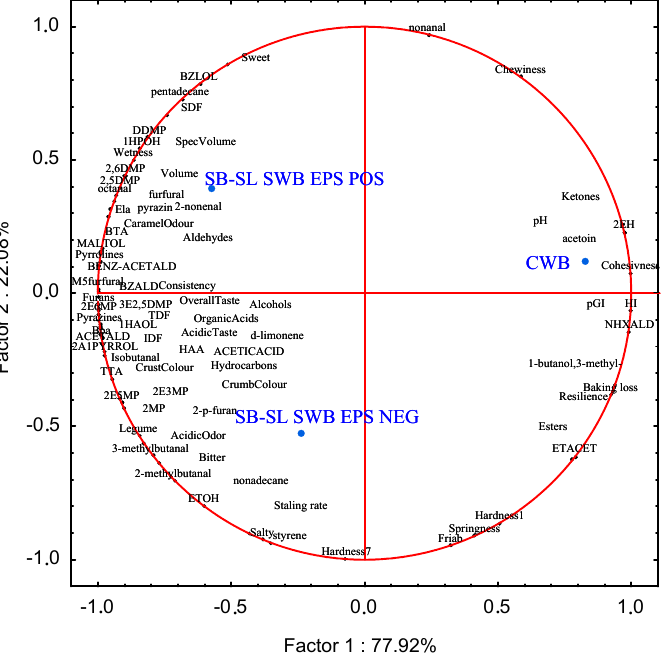
Figure 5. Correlations between physicochemical (pH, TTA, VOCs) , technological, nutritional and sensory features of control and sourdough breads (DY 162). CWB, control wheat bread started with baker’s yeast; SB-SL SWB EPS NEG, bread containing wheat flour added with 30% ( w / w ) sprouted barley-sprouted lentil (30:70% w / w ) sourdough fermented by Leuconostoc pseudomesenteroides DSM 20193; SB-SL SWB EPS POS, bread containing wheat flour added to 30% (w/w) dextran-containing sprouted barley–sprouted lentil (30:70% w / w ) sourdough fermented by L. pseudomesenteroides DSM 20193. The initial cell density of the strain was ca. 7 log cfu/g. The sourdough was fermented at 20 °C for 24 h. pH, pH bread crumb; TTA, TTA bread crumb; ETOH, ethanol; isopentanol, 1-butanol,3-